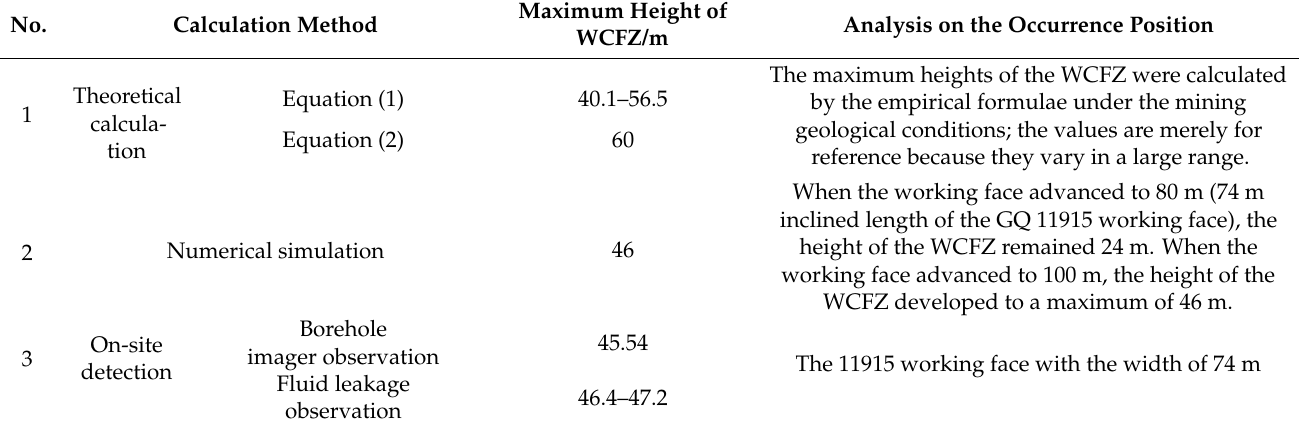
Table 6. Summary of analysis results of